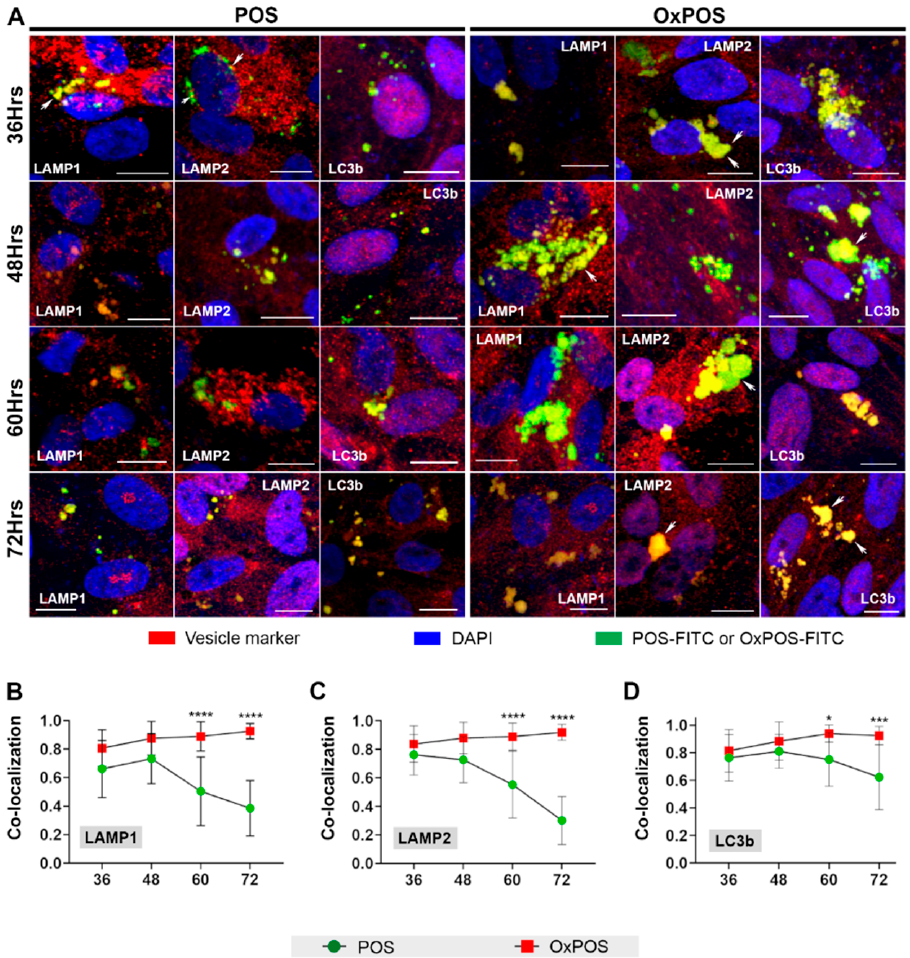
Figure 2. Evaluation of cargo tra ffi cking from 36 to 72 h. RPE cells fed POS or OxPOS were observed tra ffi cked to autophagy-lysosomal compartments. However, noticeable di ff erences between the two cargo-types were not evident until late time points. Hence, additional experiments were carried out focused on 36–72 h. ( A ) Representative confocal images showing co-localization of either POS or OxPOS (green), with specific compartments in the autophagy-lysosomal pathway (red). Areas of co-localization appear yellow (arrows). Whilst the presence of POS declined over time, RPE cells fed with OxPOS showed an accumulation of these cargos. The extent of co-localization was quantified using an unbiased automated algorithm described by Costes et al. [36], with data from the initial screen combined and shown for ( B ) LAMP1, ( C ) LAMP2 and ( D ) LC3b. OxPOS were present in a large proportion of early and mature lysosomes as well as autophagic vacuoles ( ≥ 80%), which persisted without significant change throughout the study time course. Scale bar in confocal images correspond to 10 µ m. The y-axis in graphs B–D show the extent of co-localization, where 1.0 = 100% co-localization. Data from a minimum of 9 images per time point and at least n = 10 cells / images. Statistical comparisons using a two-way ANOVA followed by Sidak’s multiple comparison test, where significant di ff erences are indicated as p ≤ 0.05 (*), p ≤ 0.001 (***) and p ≤ 0.0001 (****). The extent of POS co-localizing with early lysosomes increased from 12 h onwards and remained largely stable (from 78% at 18 h to 73% until 48 h), after which they diminished rapidly. POS tra ffi cking to mature lysosomes followed a similar pattern, where cargos reached a peak at an earlier time point of 24 h (88% of LAMP2 vesicles were positive for POS) to diminish thereafter. Most LC3b-positive compartments contained POS (77% at 12 h to 75% by 60 h), which started to diminish at 72 h (Table